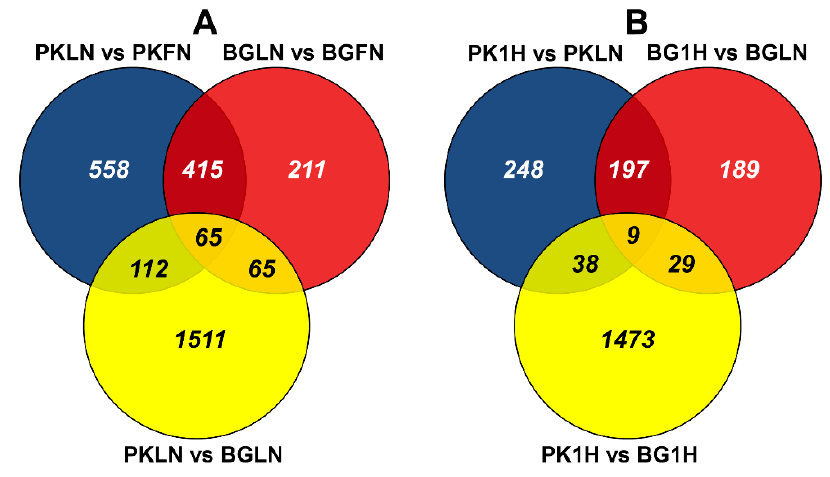
Figure 4. Venn diagrams showing differentially expressed genes (DEGs) in Pokkali and Beng al under low N stress and 1-h recovery; |log2 fold change| ≥ 2 and padj < 0.01). ( A ) Comparison of low N vs. full N, and ( B ) comparison of low N vs. 1 h after transfer to full N. Treatment groups are PKFN (Pokkali-full nitrogen), PKLN (Pokkali-low nitrogen), PK1H (Pokkali 1 h after transfer from low N to full N), BGFN (Bengal-full nitrogen), BGLN (Bengal-low nitrogen), and BG1H (Bengal 1 h after transfer from low N to full N).